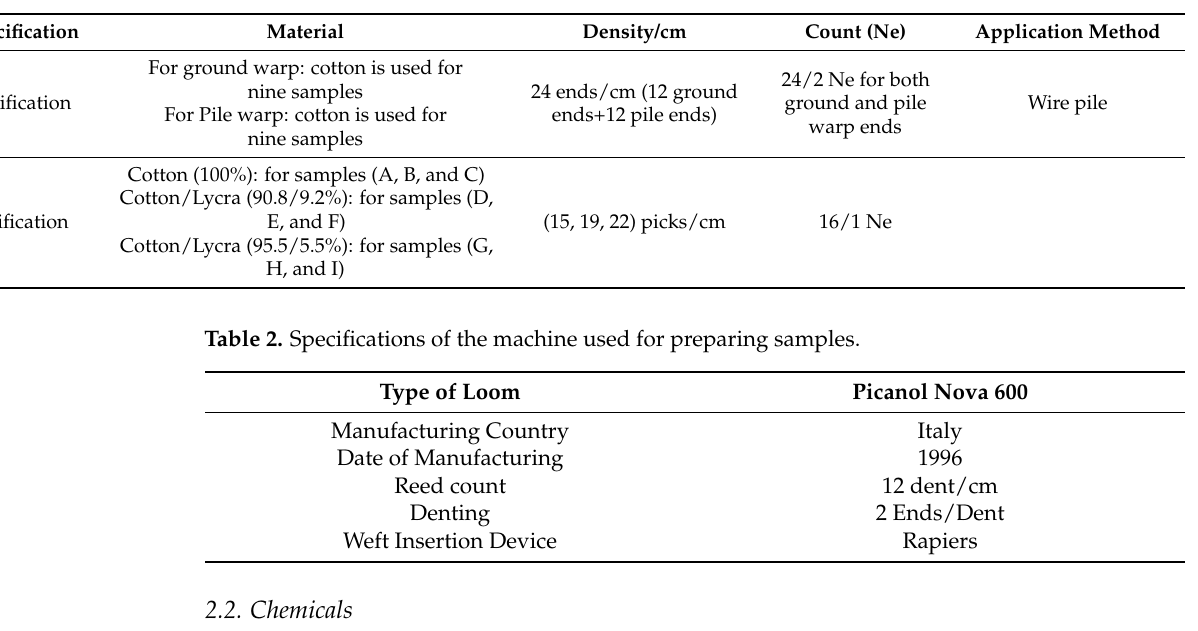
Table 1. Specification of the prepared samples.